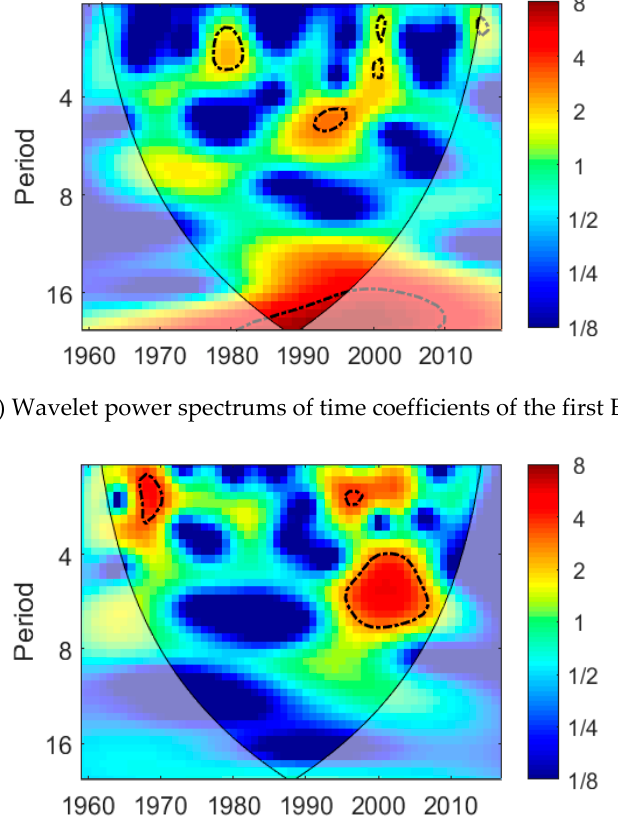
Table 2. Correlation coefficients between the East Asian Summer Monsoon Index (EASMI) and summer precipitation (SMP).